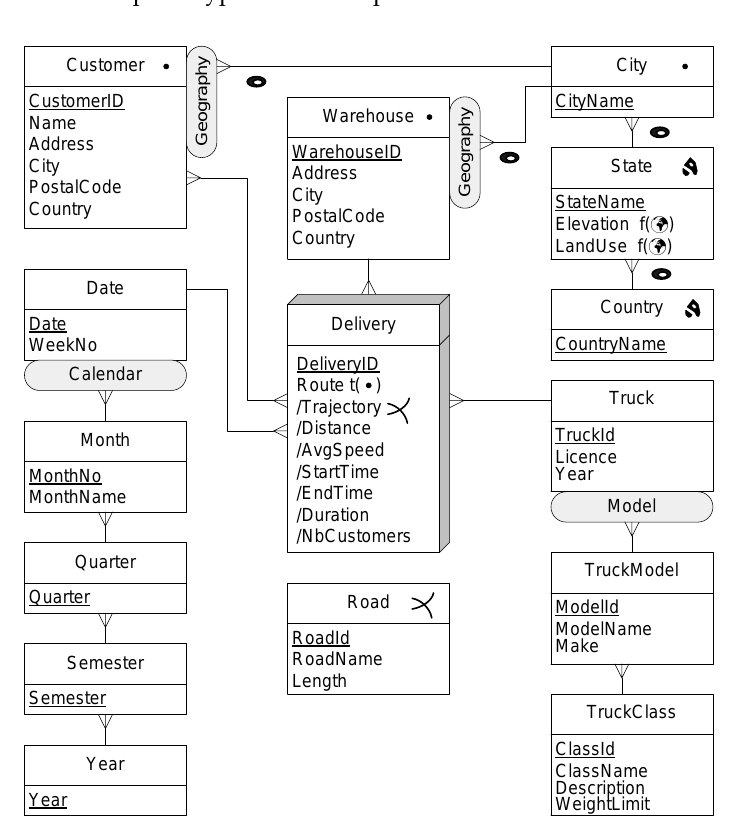
Figure 6. Conceptual schema of the Northwind mobility data